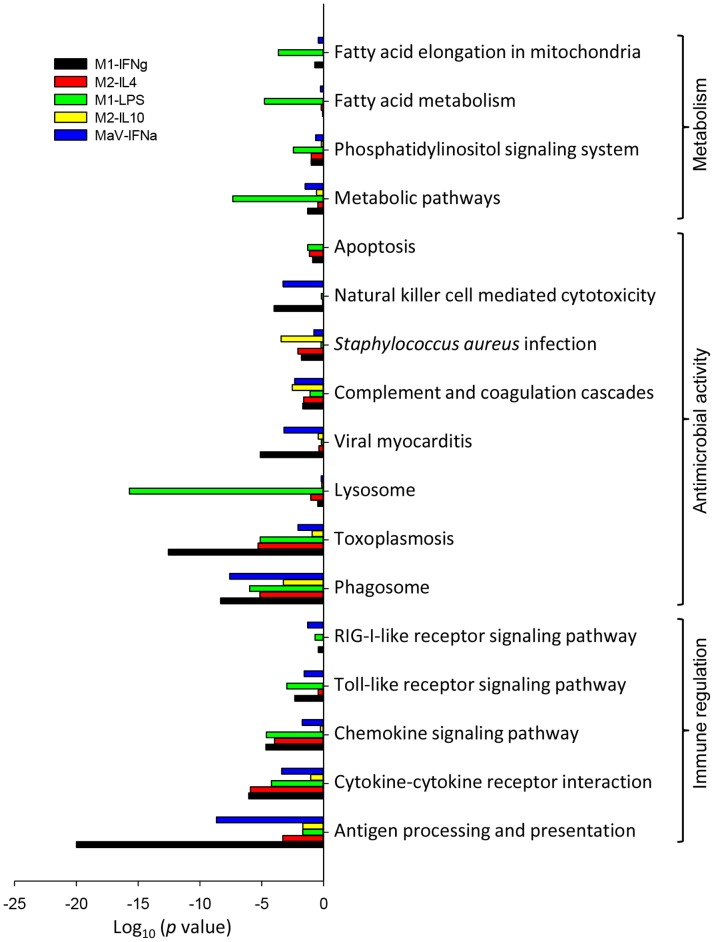
Pathway analysis of DEGs was annotated against the KEGG database.A p-value and FDR of <0.05 in the two-sided Fisher’s exact test were considered significant. Selected pathway categories are shown along the vertical axis, and the horizontal axis represents the log10 (p value) of these pathways showing the significant difference among cells at different activation statuses.